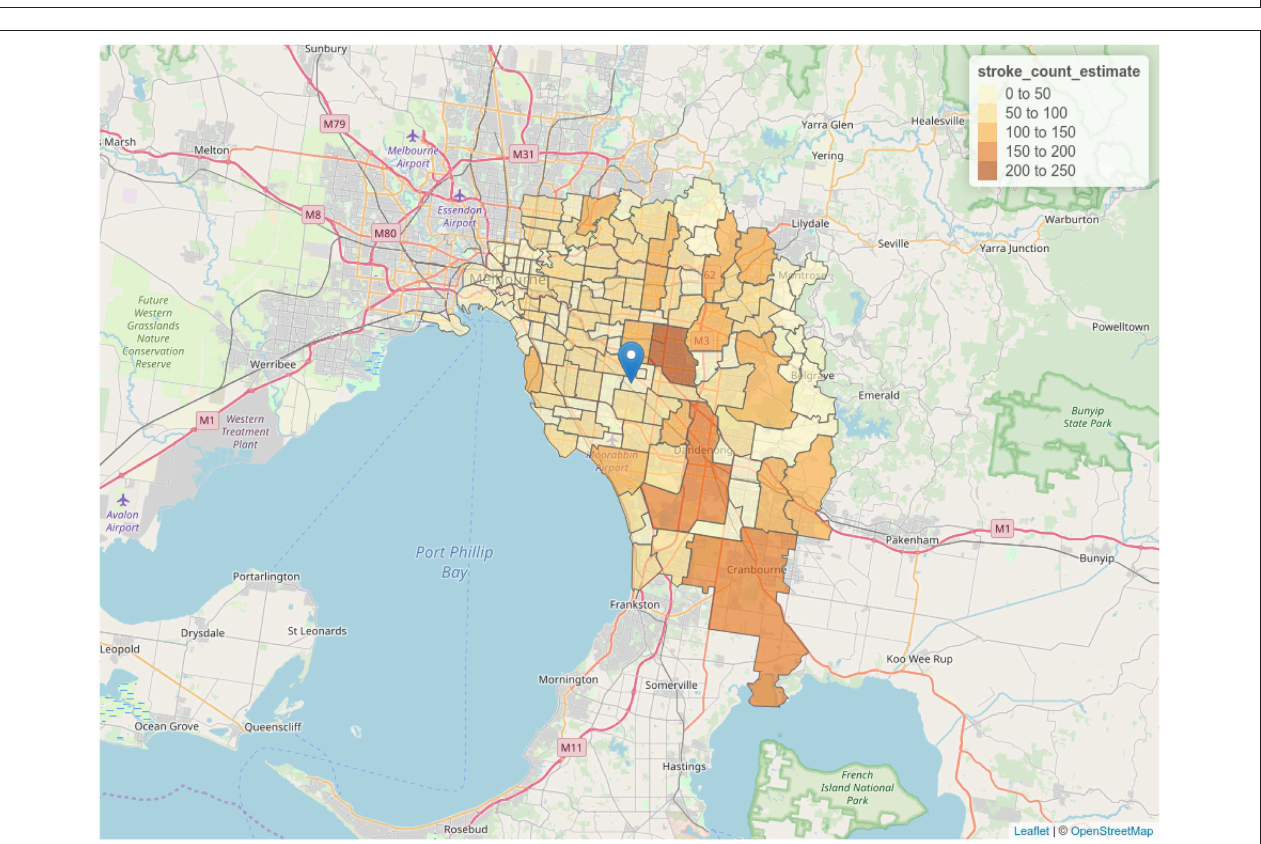
FIGURE 2 | Choropleth of stroke case load estimate. Postcodes are colored according to estimation of stroke cases derived from demographic data. Screenshot of interactive visualization created with tmap .